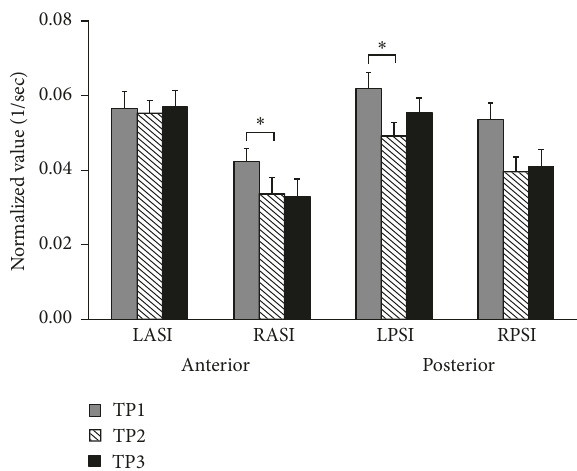
Figure 4: Normalized displacements of the Left Anterior Superior Iliacus(LASI),RightAnteriorSuperiorIliacus(RASI),LeftPosterior Superior Iliacus (LPSI), and Right Posterior Superior Iliacus (RPSI) pelvic markers are shown. Each column represents the difference between the vertical positions of the same marker measured at the beginning and end of the turning normalized by the duration of turn and leg length. Significant difference ( 𝑝 < 0.05 ) is shown with